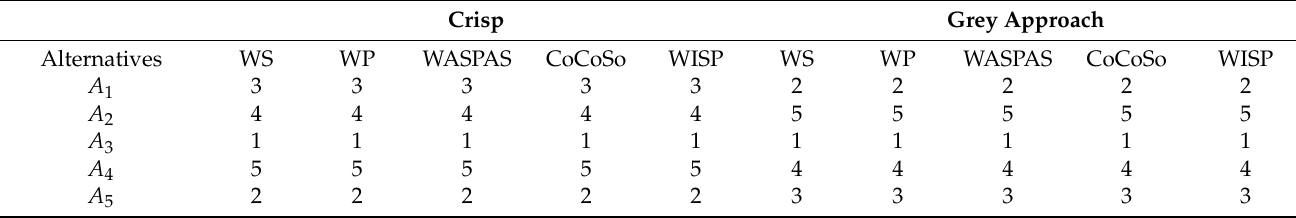
Table 16. Ranking orders of alternatives obtained on the basis of 50 virtual respondents.